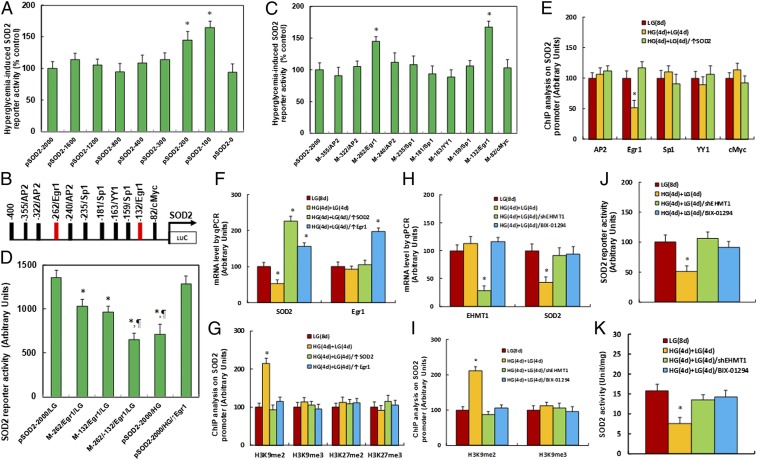
Hyperglycemia induces SOD2 suppression through histone methylation and the subsequent decreased association of Egr1 on the SOD2 promoter. (A) The conditional immortalized ACS-5003 neurons were transiently transfected by either SOD2 full length (pSOD2-2000) or deletion reporter plasmids. After 24 h, the cells were treated by either 5 mM low glucose (LG) or 25 mM high glucose (HG) for 3 d, and the SOD2 reporter activities were calculated (n = 4; *P < 0.05 vs. pSOD2-2000 group). (B) The schematic picture for the potential transcriptional binding motif in the range of approximately −400 to 0 (from transcription start site) on the SOD2 promoter in addition to the 2 potential Egr1 binding sites are marked in red. (C) The cells were transiently transfected by either wild type SOD2 reporter construct (pSOD2-2000) or single point mutation at the site shown in B and then treated with either LG or HG for 3 d, and the SOD2 reporter activities were calculated (n = 4; *P < 0.05 vs. pSOD2-2000 group). (D) The cells were transiently transfected by SOD2 full length (pSOD2-2000) or single point mutation as indicated or infected by Egr1 lentivirus (↑Egr1), and were then treated with either LG or HG for 3 d; the SOD2 reporter activities were then calculated (n = 4; *P < 0.05 vs. pSOD2-2000/LG group; ¶P < 0.05 vs. M-262/Egr1/LG group). (E) Cells were treated by either 8-d LG [LG(8 d)], or 4-d HG plus 4-d LG [HG(4 d)+LG(4 d)] or the cells were infected on day 4 by SOD2 lentivirus [HG(4 d)+LG(4 d)/SOD2↑]; the cells were then used for ChIP analysis [n = 4; *P < 0.05 vs. LG(8 d) group]. (F and G) Cells were treated by either LG(8 d) or HG(4 d)+LG(4 d) or the cells were infected on day 4 by SOD2 [HG(4 d)+LG(4 d)/↑SOD2] or Egr1 lentivirus [HG(4 d)+LG(4 d)/↑Egr1]; the cells were then used for ChIP analysis [n = 4; *P < 0.05 vs. LG(8 d) group]. (H–K) Cells were treated by either LG(8 d) or HG(4 d)+LG(4 d), and the cells were infected on day 4 by shEHMT1 lentivirus [HG(4 d)+LG(4 d)/shEHMT1] or cells were treated on day 4 by EHMT1 inhibitor BIX-01294 [HG(4 d)+LG(4 d)/BIX-01294]; then, cells were used for the following further analysis: (H) mRNA analysis (n = 4), (I) ChIP analysis by H3K9me2 and H3K9me3 antibodies (n = 4), (J) SOD2 reporter activity assay (n = 5), and (K) SOD2 activities [n = 5; *P < 0.05 vs. LG(8 d) group]. Data are expressed as mean ± SEM.